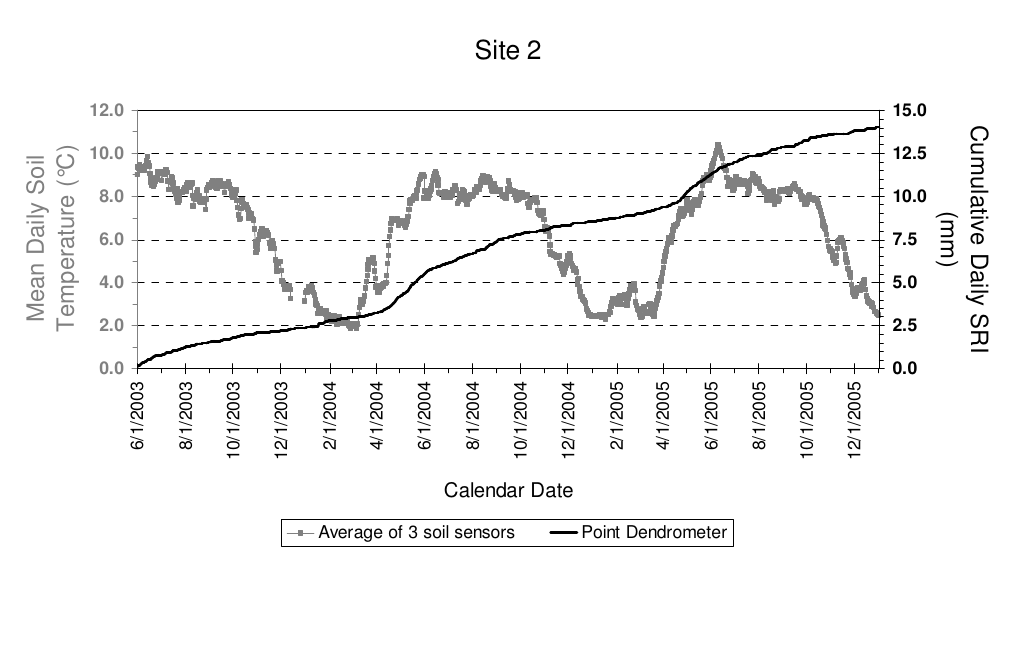
Figure 5. Stem radial size (cumulative daily SRI, black) at Site 2 from June 1st, 2003 to January 1st, 2005. Maximum growth rates occurred in the late spring, when soil temperature measured at the site (gray) increased above 4–6